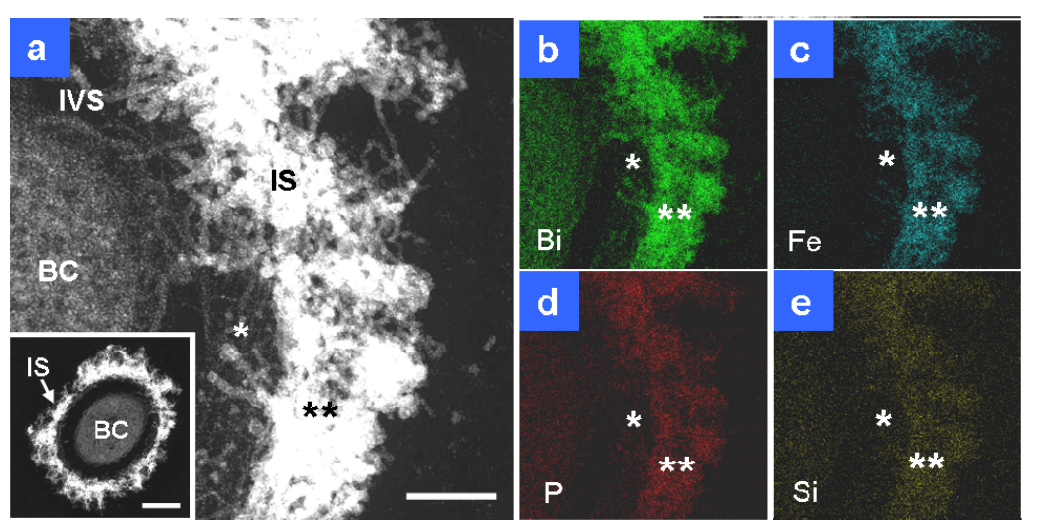
Figure 3. HAADF-STEM images of OUMS1 and associated structures in Bi-stained cross sections prepared from a two-day-old culture and elemental maps by EDX area analysis. ( a ) Enlarged image of a bacterial cell with an immature sheath shown in inset. Note the highly electron-dense outer layer composed of intermingled fibrils (double star), suggesting a heavy deposition of aqueous-phase inorganic elements. The fibrils of the inner layer (single star) were much thicker than those in one-day-old culture (Figure 2(a)); ( b ) Bi map showing intense signals in the cell and the immature sheath; ( c ) Fe distribution map showing intense signals, particularly in fibrils of the outer sheath layers; ( d ) P distribution map showing intense signals, particularly in the sheath fibrils; ( e ) Si distribution map showing intense signals, particularly in the sheath fibrils. Scale bar = 100 nm, except 500 nm in (a) inset. BC, bacterial cell; CE, cell envelope; IS, immature sheath; IVS, intervening space.